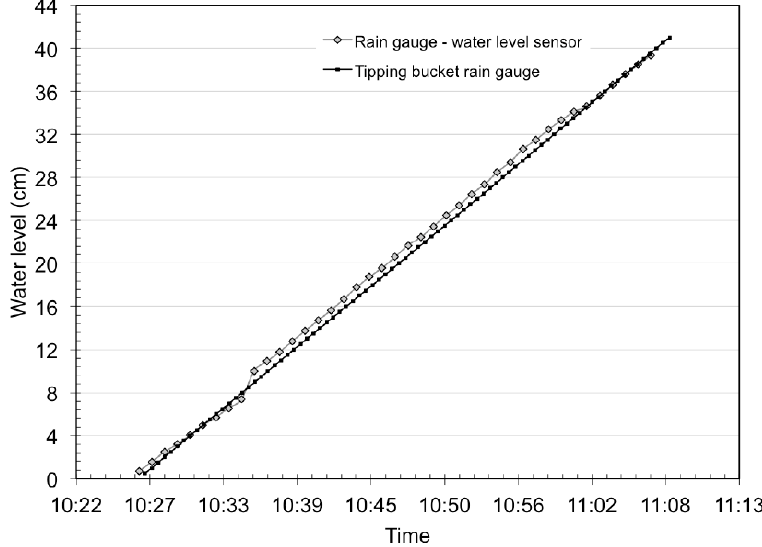
Figure 5. Rain gauge test in laboratory. Comparison between the rain gauge using the capacitive sensor and a reference tipping bucket rain